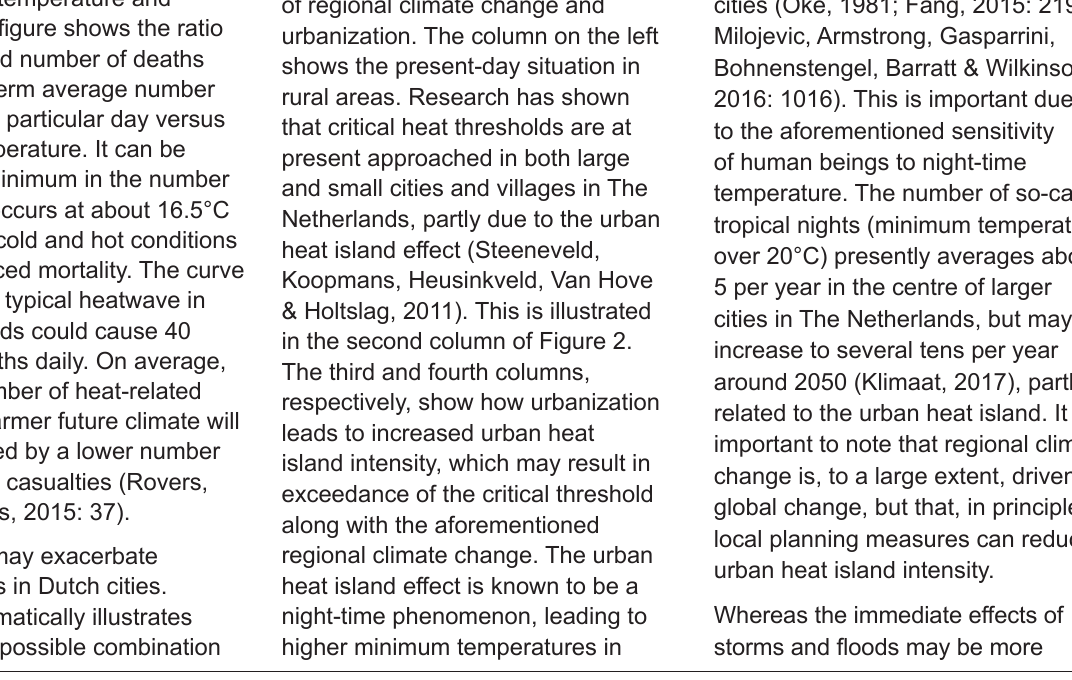
Figure 2: Influence of climate change and urbanisation on heat stress. Urbanisation affects the urban heat island (UHI). See main text for further explanation.